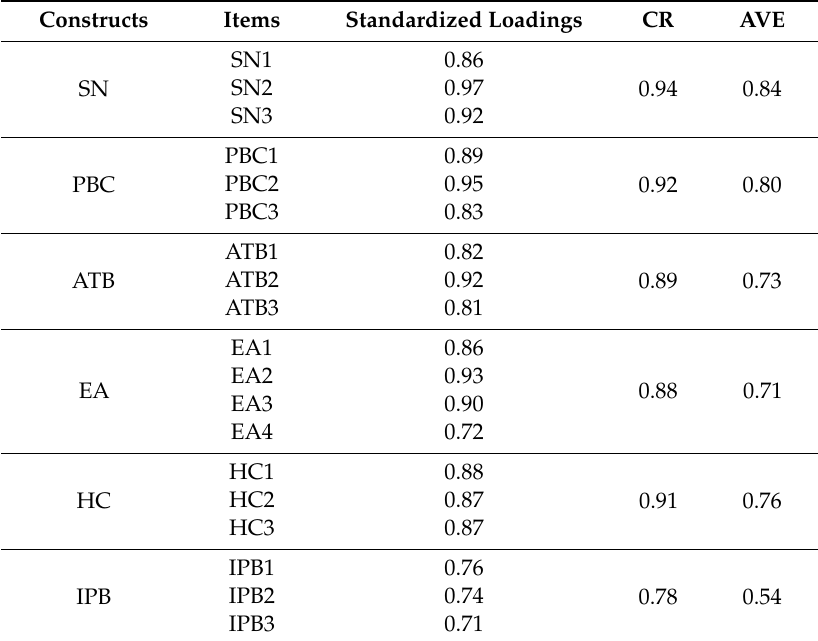
Table 3. Statistics of construct items.